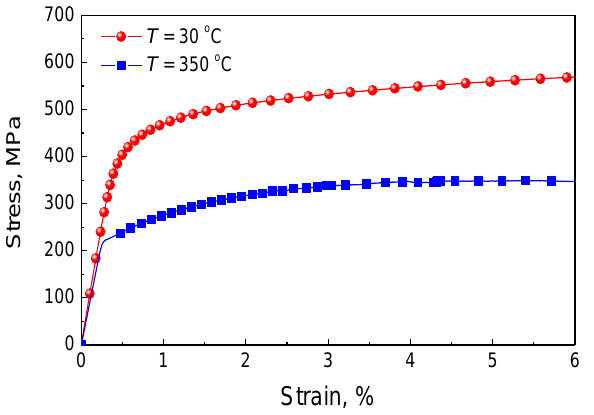
◦ C and 350 ◦ C of TA16 titanium alloy.